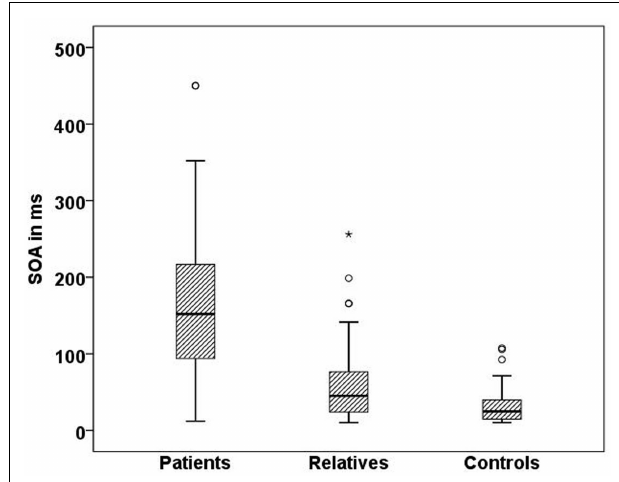
FIGURE 4 | Mean SOA in milliseconds for each Georgian group . Schizophrenic patients ( n = 50) perform worse than healthy relatives ( n = 57) and controls ( n = 51), SD = 81.7, p < 0.001.